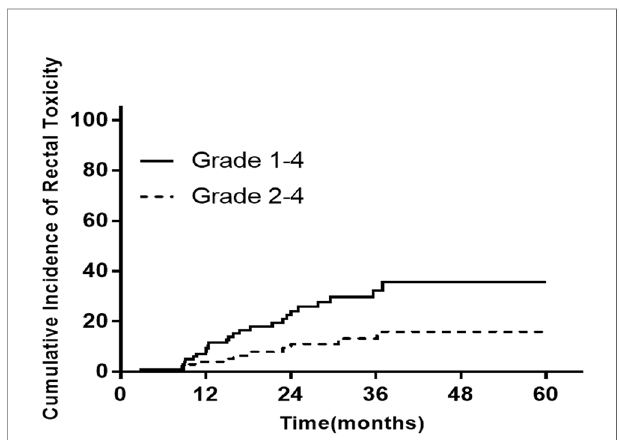
FIGURE 1 | The incidence of late rectum morbidity in patients with locally advanced cervical cancer at 1/3/5 years.